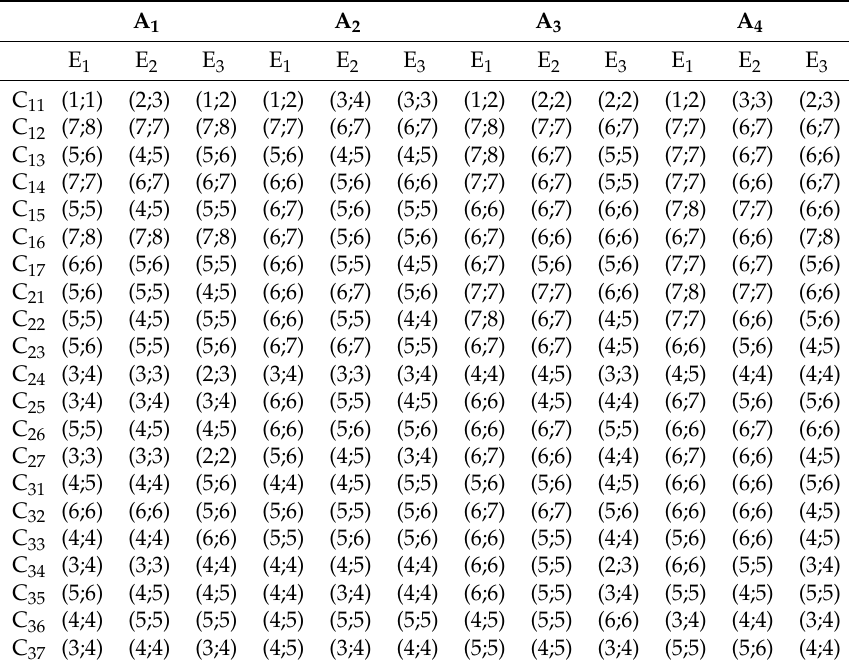
Table 2. Evaluation of alternatives by three